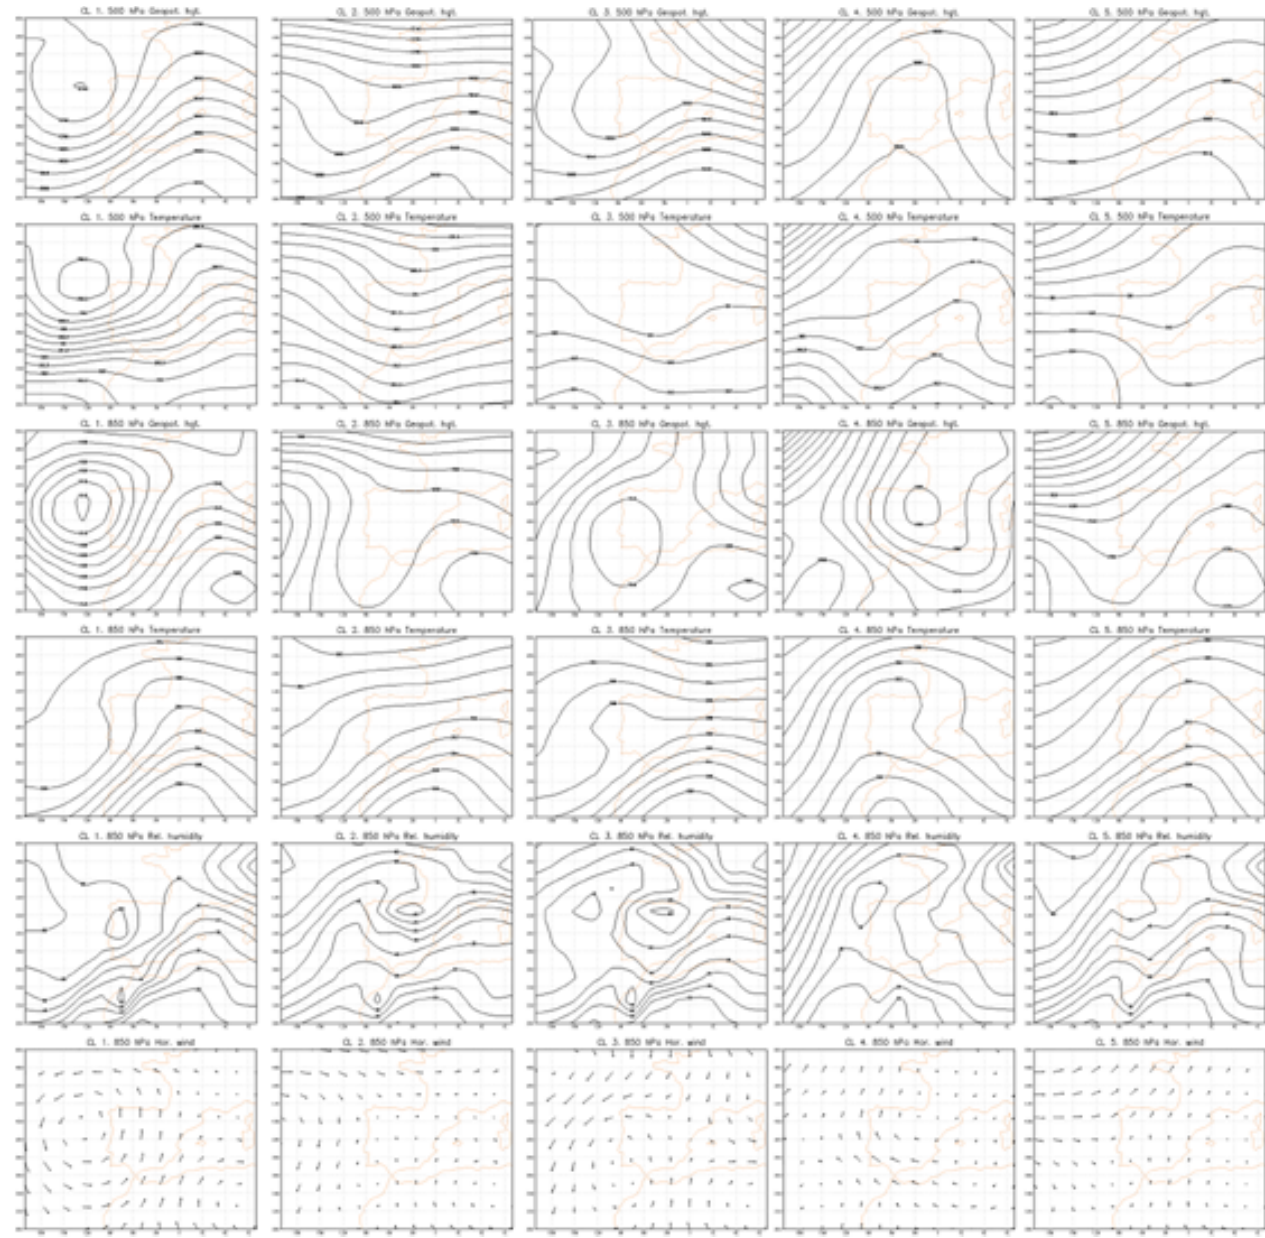
Fig. 3. Results obtained by the Cluster Analysis. The clusters are numbered following the order obtained in the k-mean output. Clusters 1 to 5 labelled as CL1, CL2,..., CL5 in the columns. The atmospheric fields are in rows: φ 500 (gpm), T 500 (K), φ 850 (gpm), T 850 (K), rh 850 (%) and horizontal wind direction at 850hPa from top to